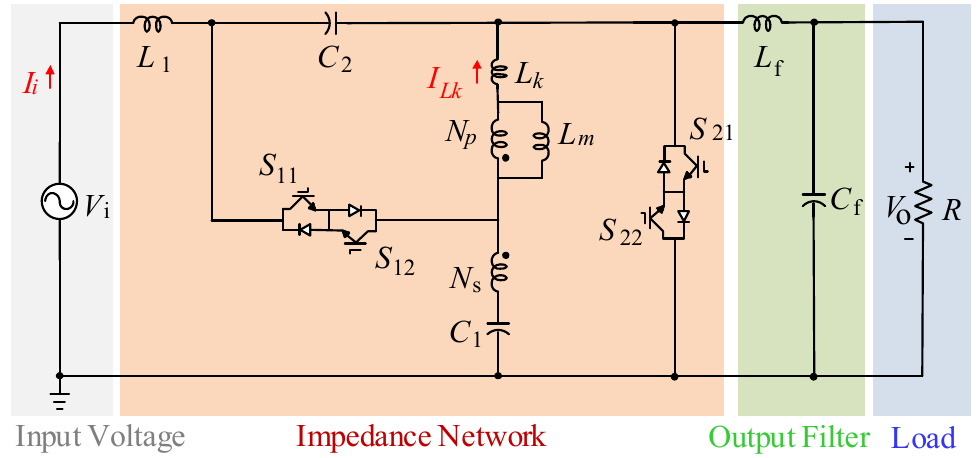
Figure 3. Trans-inverse magnetic coupling single-phase AC-AC converter.